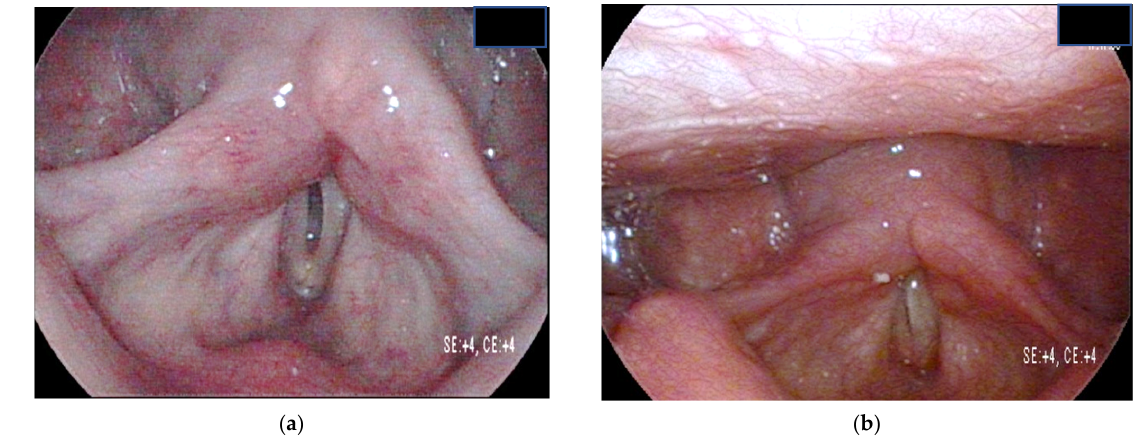
Figure 3. Stroboscopy images of Case 3 ( a ) preoperatively with maximal abduction without trache- ostomy and ( b ) post-arytenoidectomy and tracheostomy showing increased spasm. Four months after revision tracheostomy placement, the patient developed progres- sive difficulty speaking and one-way speaking valve intolerance. Videolaryngostro- boscopy (VLS) demonstrated complete fixation of the posterior glottis and laryngeal hy-